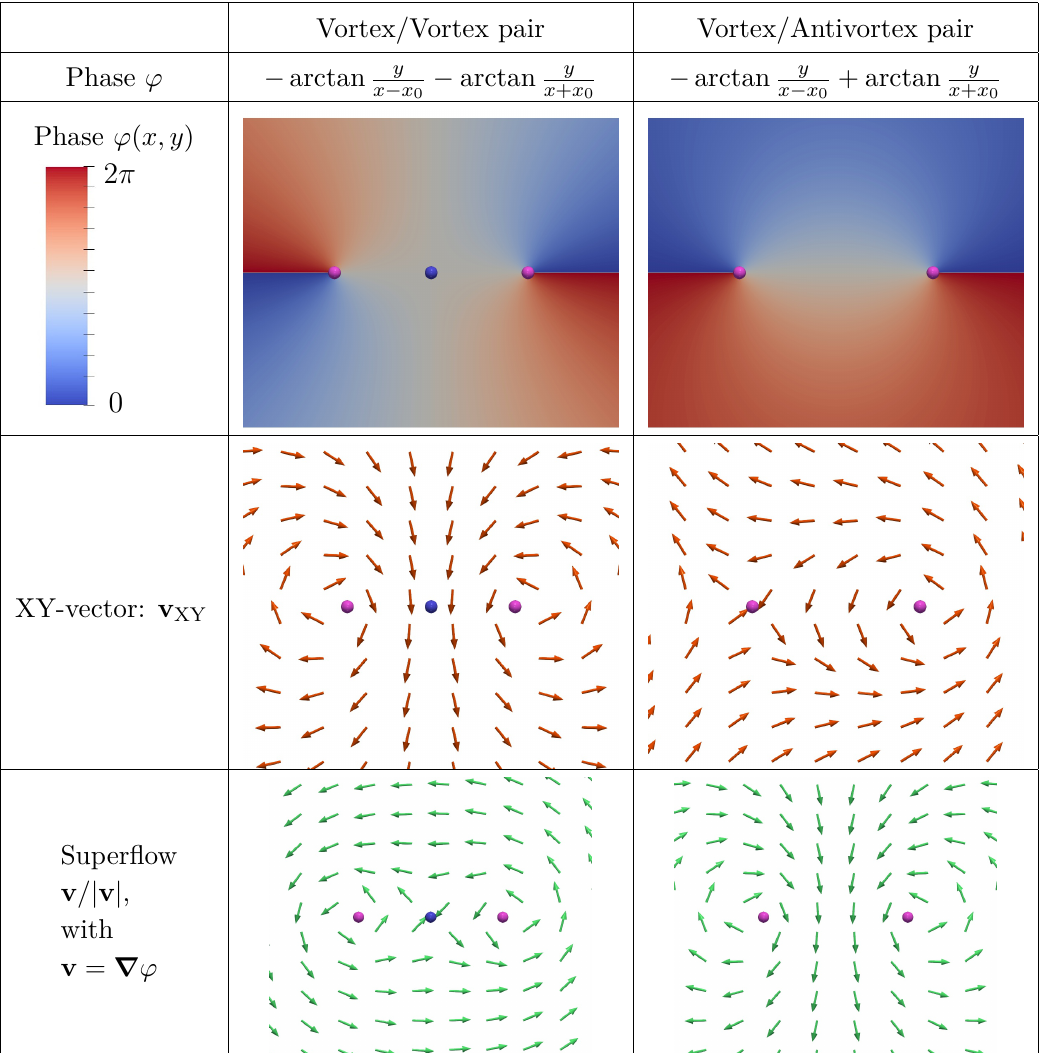
Table 2 . The figures compare the difference between a vortex-vortex pair and a vortex-antivortex pair, as fixed points of the XY-vector eq. (A.1) and superflow vector field v in eq. (2.1). The vortex and antivortex are respectively a center and a saddle, of the XY-vector field v XY . On the other hand, they are both centers of the vector field v . The red dots are the positions of the phase singularities. The blue dots show the position of the velocity vector field saddle point. It is notable that the saddle of the superflow is not associated with a phase singularity, but is a stagnation point of v